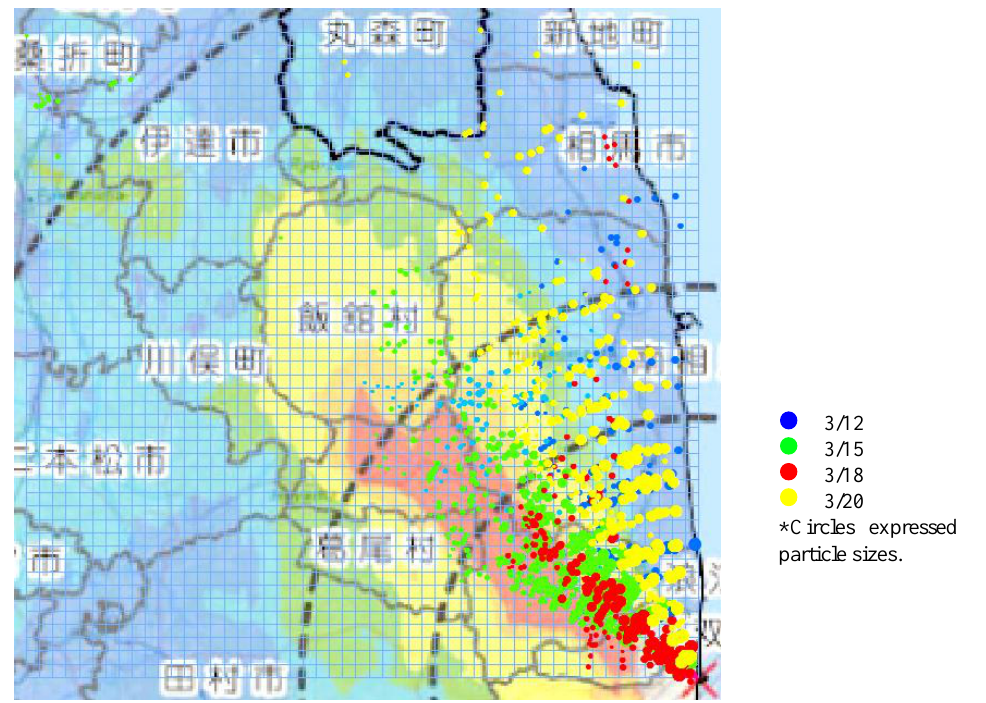
Figure 12. Radioisotope falling points on March 12, 15, 18, and